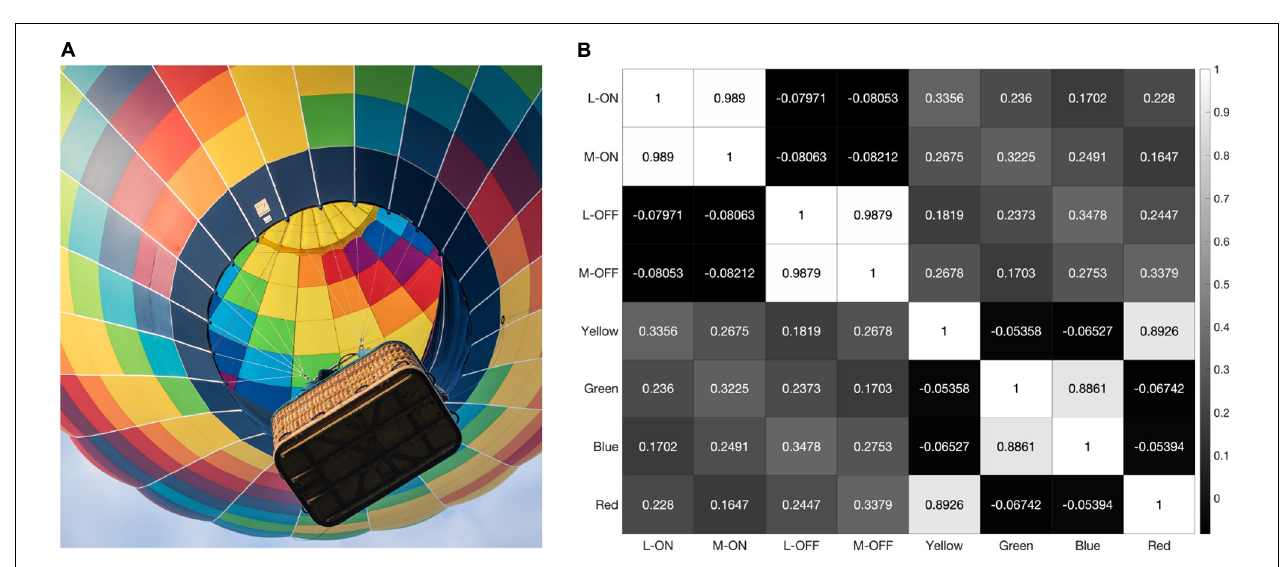
FIGURE 7 | When presented with the image shown in panel (A) our model produces the correlation matrix in panel (B) .